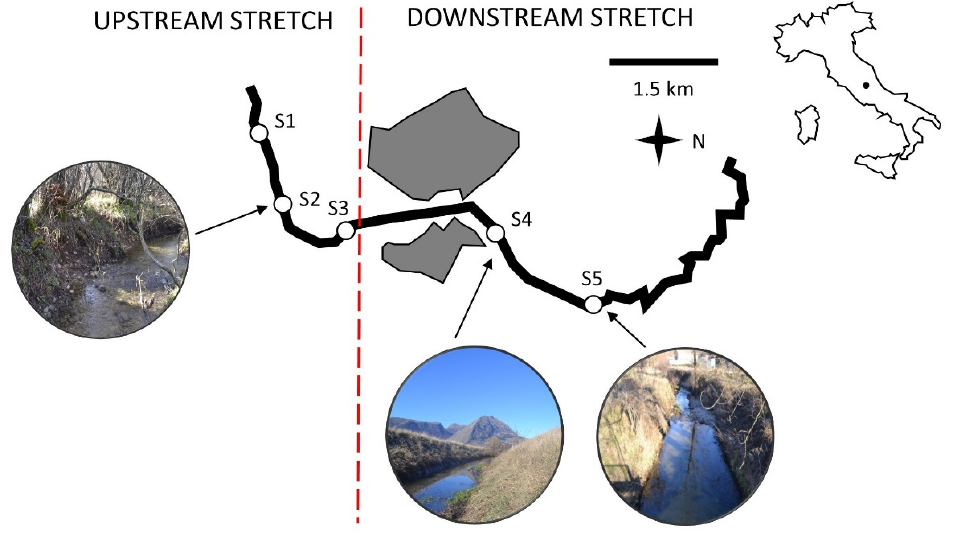
Figure 1. The Rio Gamberale creek and sampling stations (white dots and pics). Urban areas served by wastewater treatment plants are represented in grey.